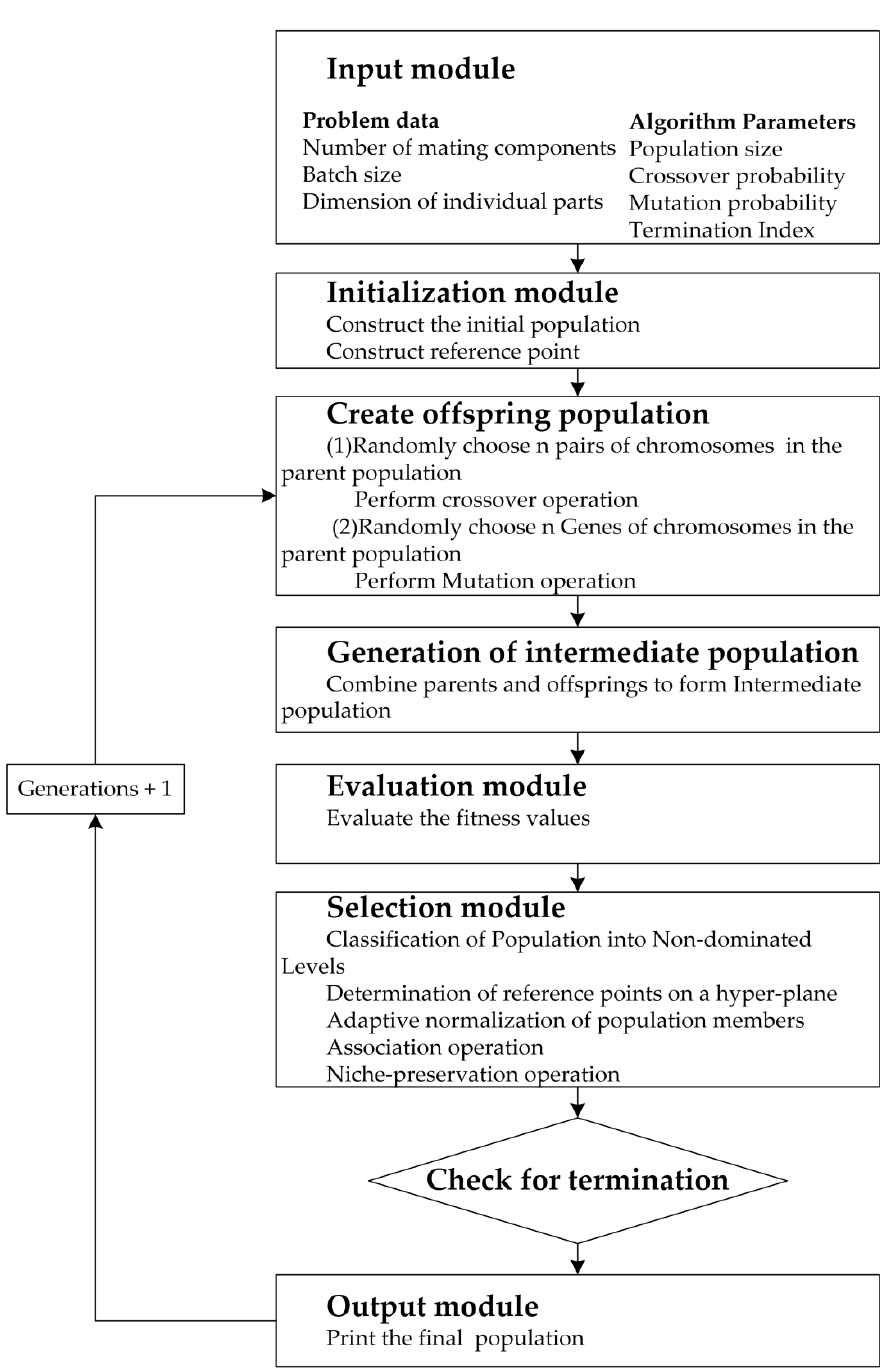
Figure 11. Flowchart of the proposed NSGA-III-I for batch selective assembly.